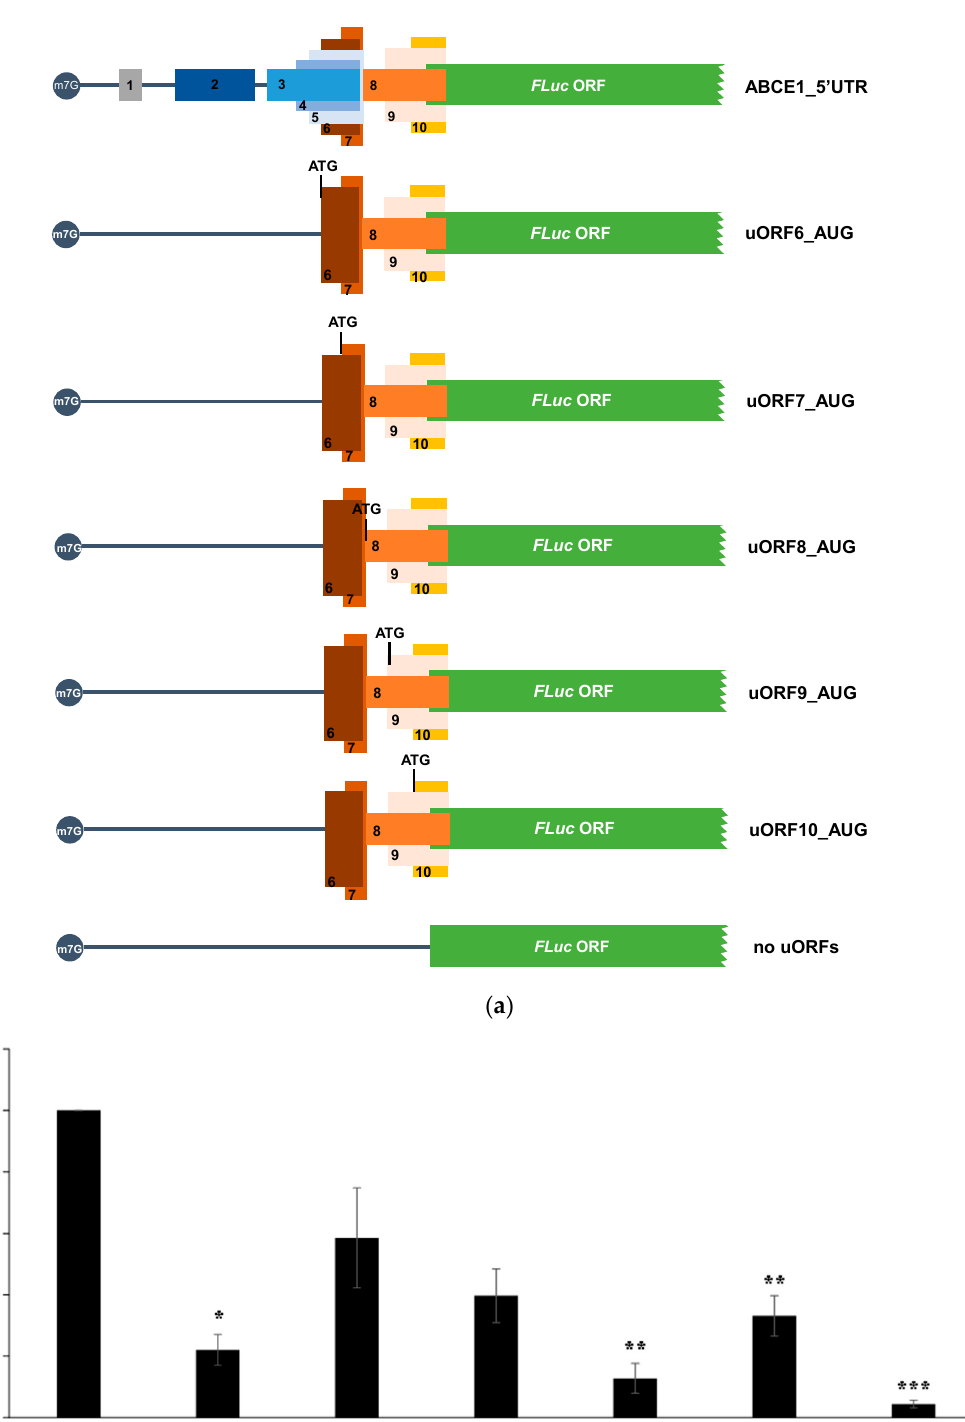
12 of 29 Figure 3. The non-AUG uORFs within the ABCE1 mRNA 5 ′ -leader sequence do not seem to significantly repress transla- tion of the main ORF. ( a ) Schematic representation of the constructs used to study the translational regulatory function of the ABCE1 non-AUG uORFs. The ABCE1_5 ′ UTR, containing the intact ABCE1 5 ′ -leader sequence, was already described in Figure 2a. By site-directed mutagenesis and using the “no AUG uORFs” construct as a template, each non-AUG initia- tion codon was mutated (CTG/GTG → GCG), creating the constructs with only one functional non-AUG uORF (uORF6-10, represented here by small boxes and only by its uORF number, 6 to 10, to simplify the scheme) or without any uORF (called “no uORFs”). ( b ) Expression of each construct was analyzed as described in Figure 2b legend, but using “no uORFs” construct expression data for the comparison analysis. The results are presented as mean ± SEM from at least three independent experiments. Student’s t-test was applied for statistical significance: p < 0.05 (*). We next examined if the lack of inhibitory activity observed for the ABCE1 non-AUG uORFs is due to their frequent ribosomal bypass as a consequence of the non-canonical nature of their start codons. For that, the start codon of each of the non-AUG uORFs was mutated to an AUG (CTG/GTG → ATG), using as template the construct “no AUG uORFs”, obtaining the constructs named uORF6_AUG, uORF7_AUG, uORF8_AUG, uORF9_AUG, and uORF10_AUG (Figure 4a). In each construct, only one of the non-AUG